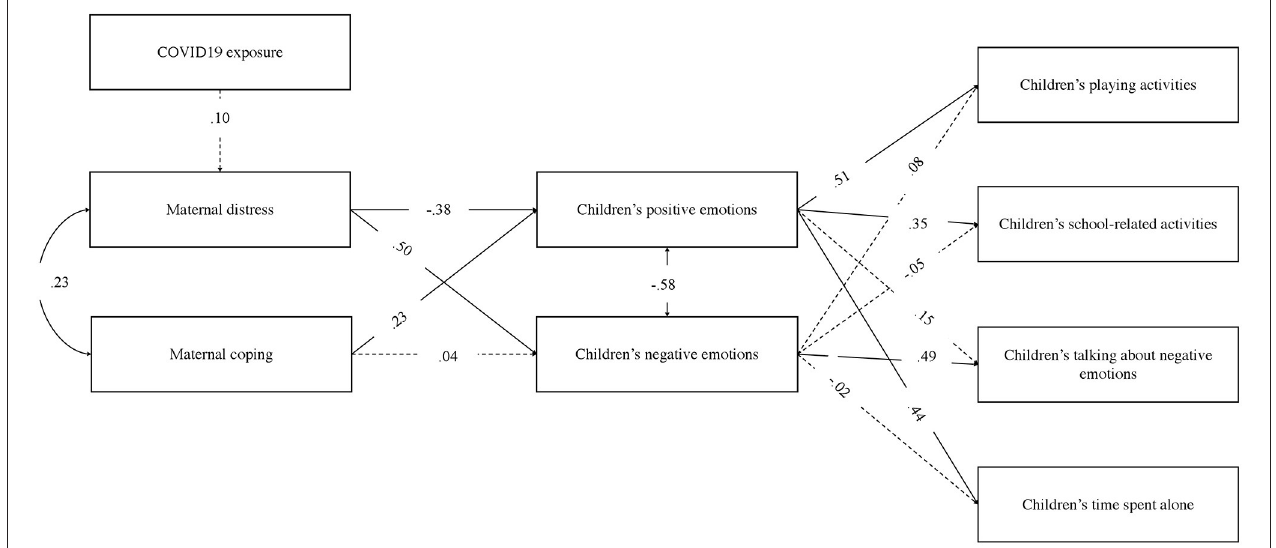
FIGURE 2 | The final model. Only standardized path coefficients are shown. Dashed arrows denote non-significant paths; all other paths denote significant relationships at p < 0.05.